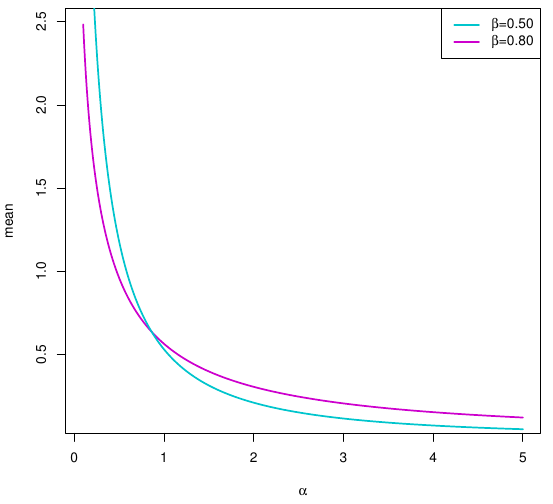
Figure 7. The influence of α on the mean of the Chen distribution when β is fixed.